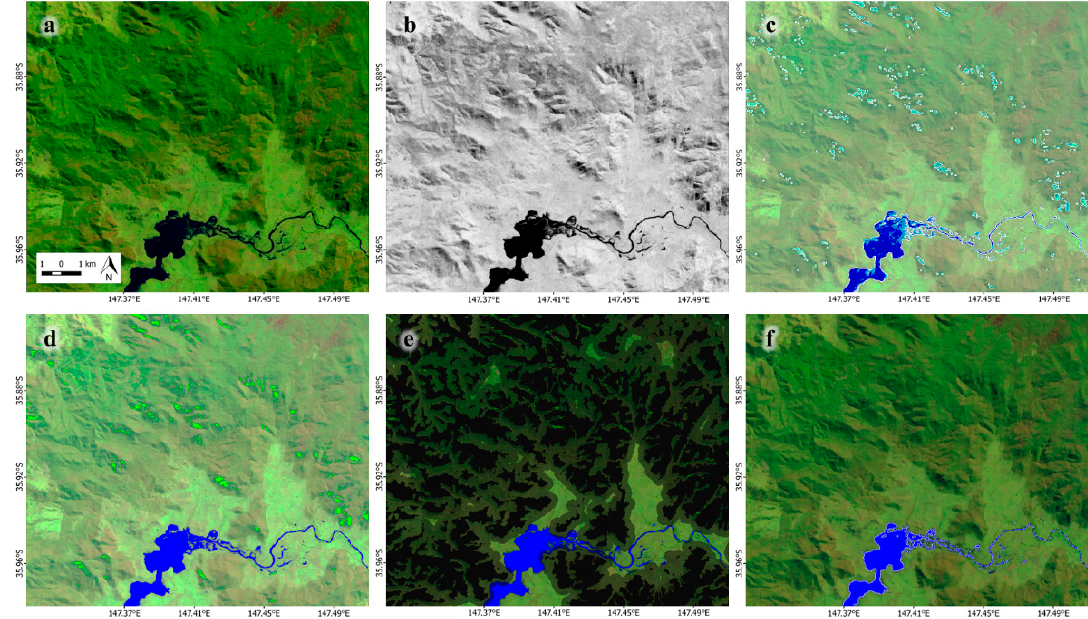
Figure 11. Steps performed during supervised classification post-processing step for hillslope areas.